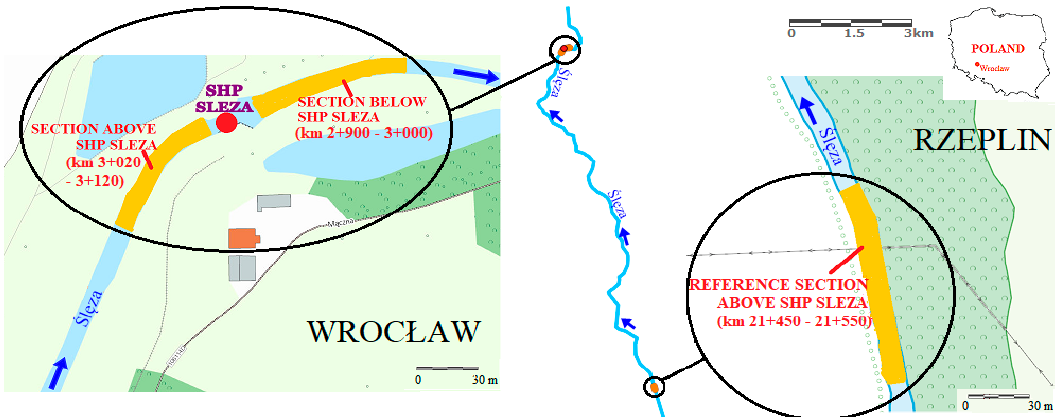
Figure 1. The location of the research sections in the Macrophyte Index for Rivers MMOR method— above and below the small hydropower plant (SHP) Ś l ę za (including the reference